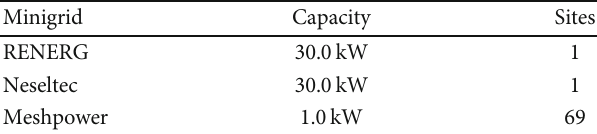
Table 23: Solar PV minigrids in Rwanda.